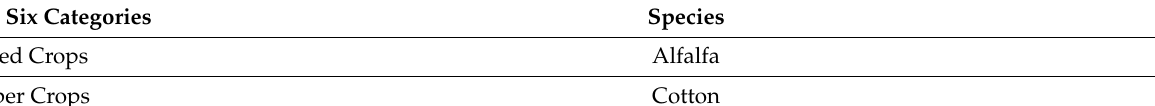
Table 1. Summary of gene-edited crop species using CRISPR/Cas9 system.